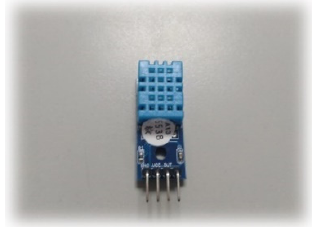
Figure 13. Temperature sensor DHT-22.